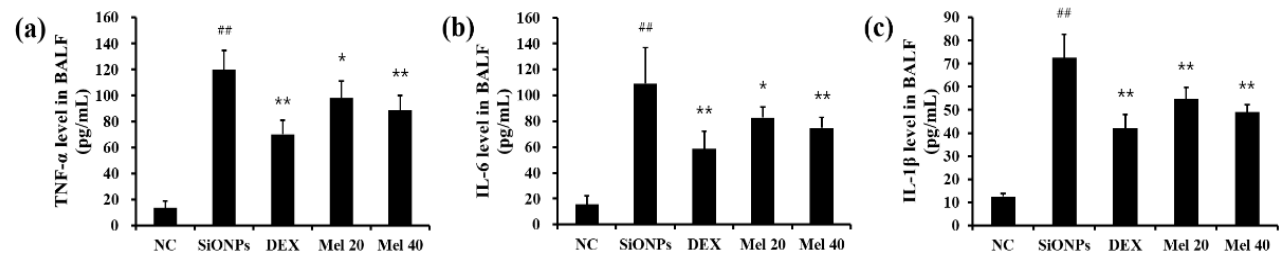
Figure 2. Melatonin reduced the levels of cytokine in SiONPs-exposed mice. ( a ) TNF- α , ( b ) IL-6 , and ( c ) IL- 1β levels in BALF. Cytokine levels were measured using an ELISA. ## p < 0.01, vs. the NC; * p < 0.05, ** p < 0.01, vs. the SiONPs.